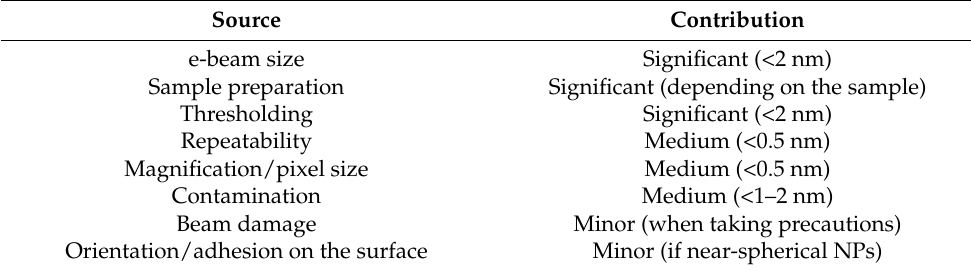
Table 3. Main uncertainty sources for NP size measurements by